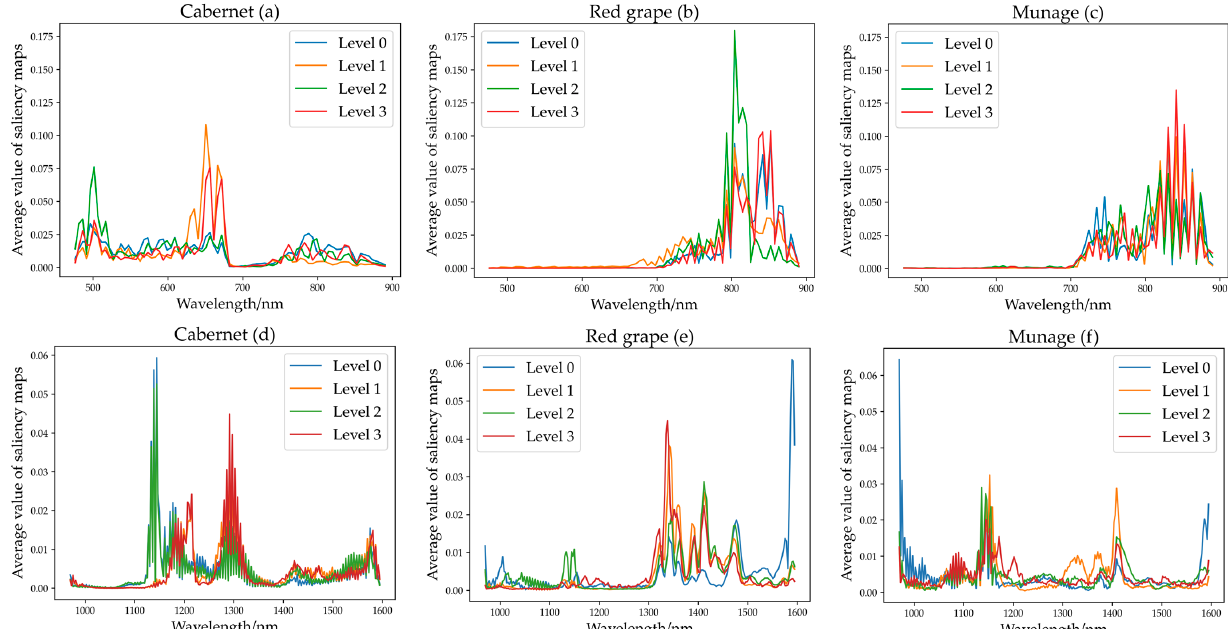
Figure 7. ( a – c ) mean average value of saliency map of ResNet for Cabernet, Red grape, and Munage for Vis-NIR spectra. ( d – f ) mean that of ResNet for Cabernet, Red grape, and Munage for NIR spectra.